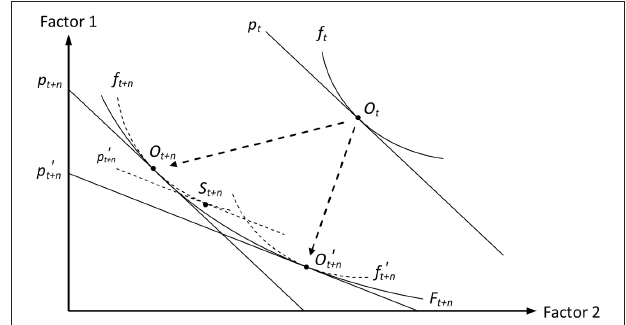
FIGURE 1 | Induced technical change as a dynamic production